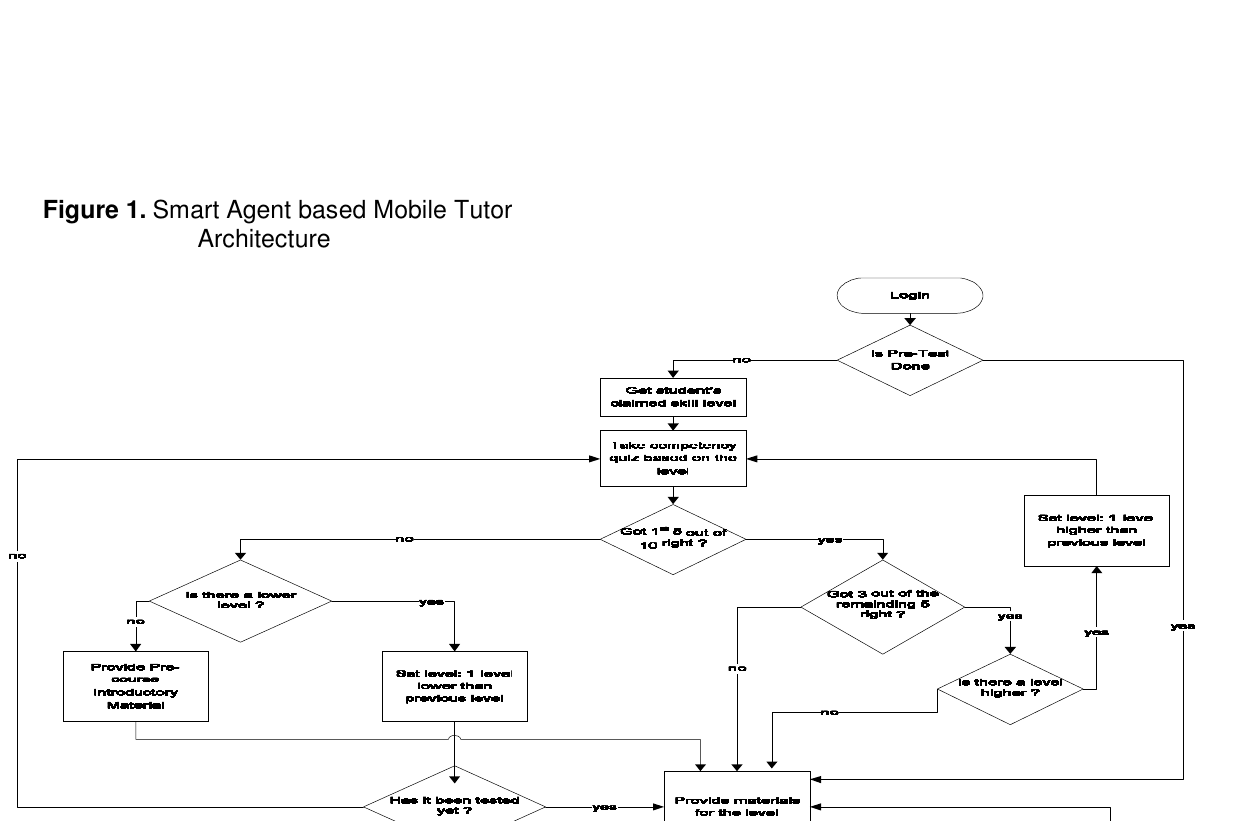
Figure 1. Smart Agent based Mobile Tutor Architecture